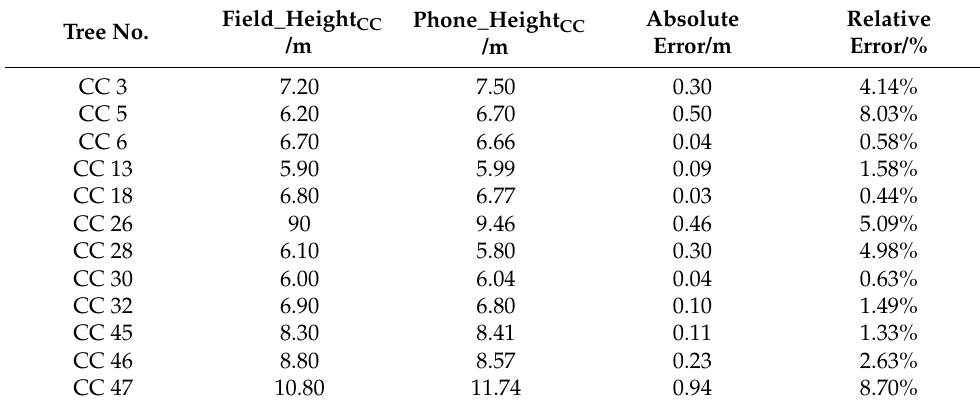
Table 2. The Field_Height CC , Phone_Height CC and error analysis. Tree No.